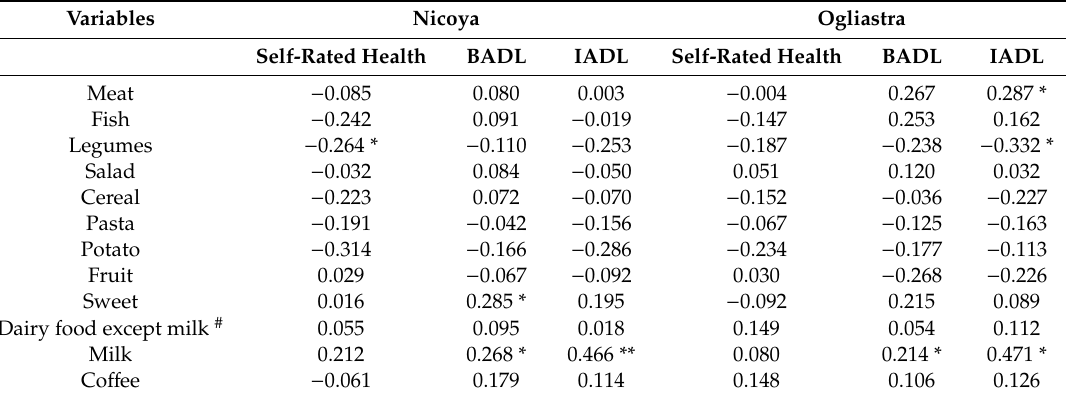
Table 4. Correlation between frequency of consumption and health status in the elderly of Nicoya and